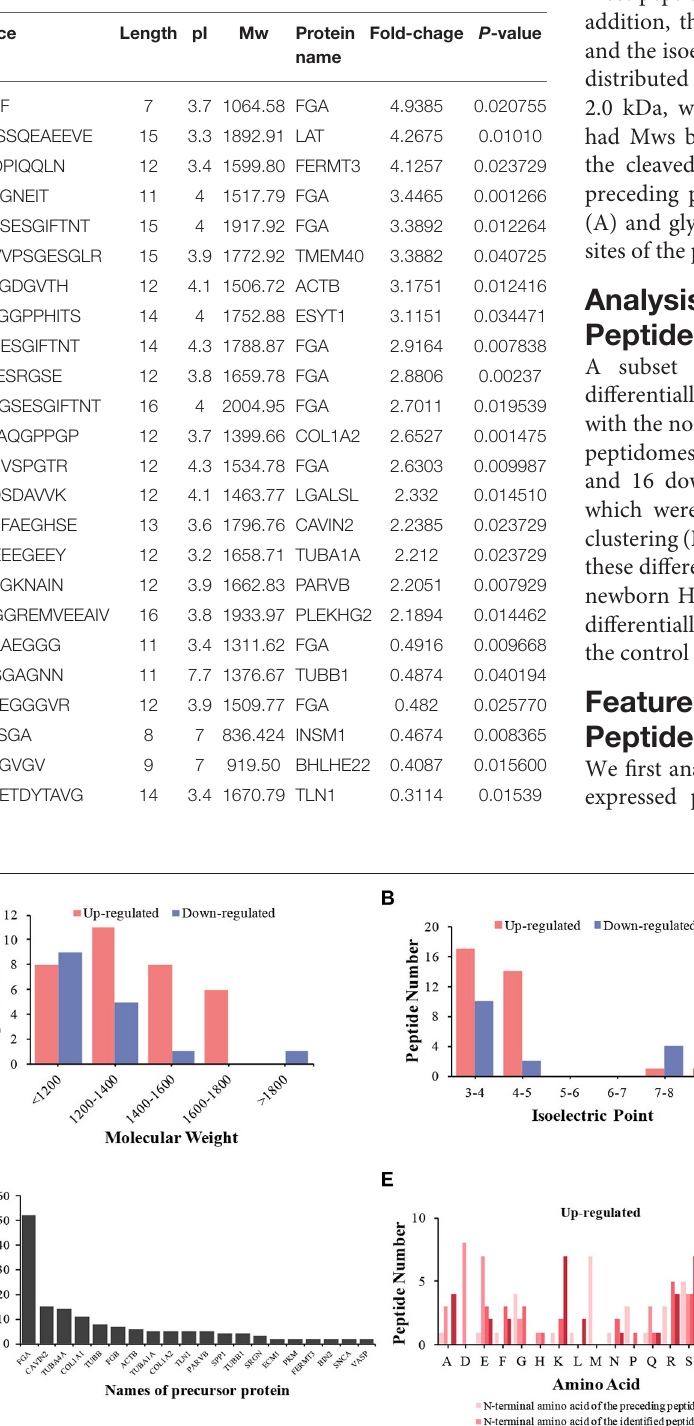
Frontiers in Pediatrics |